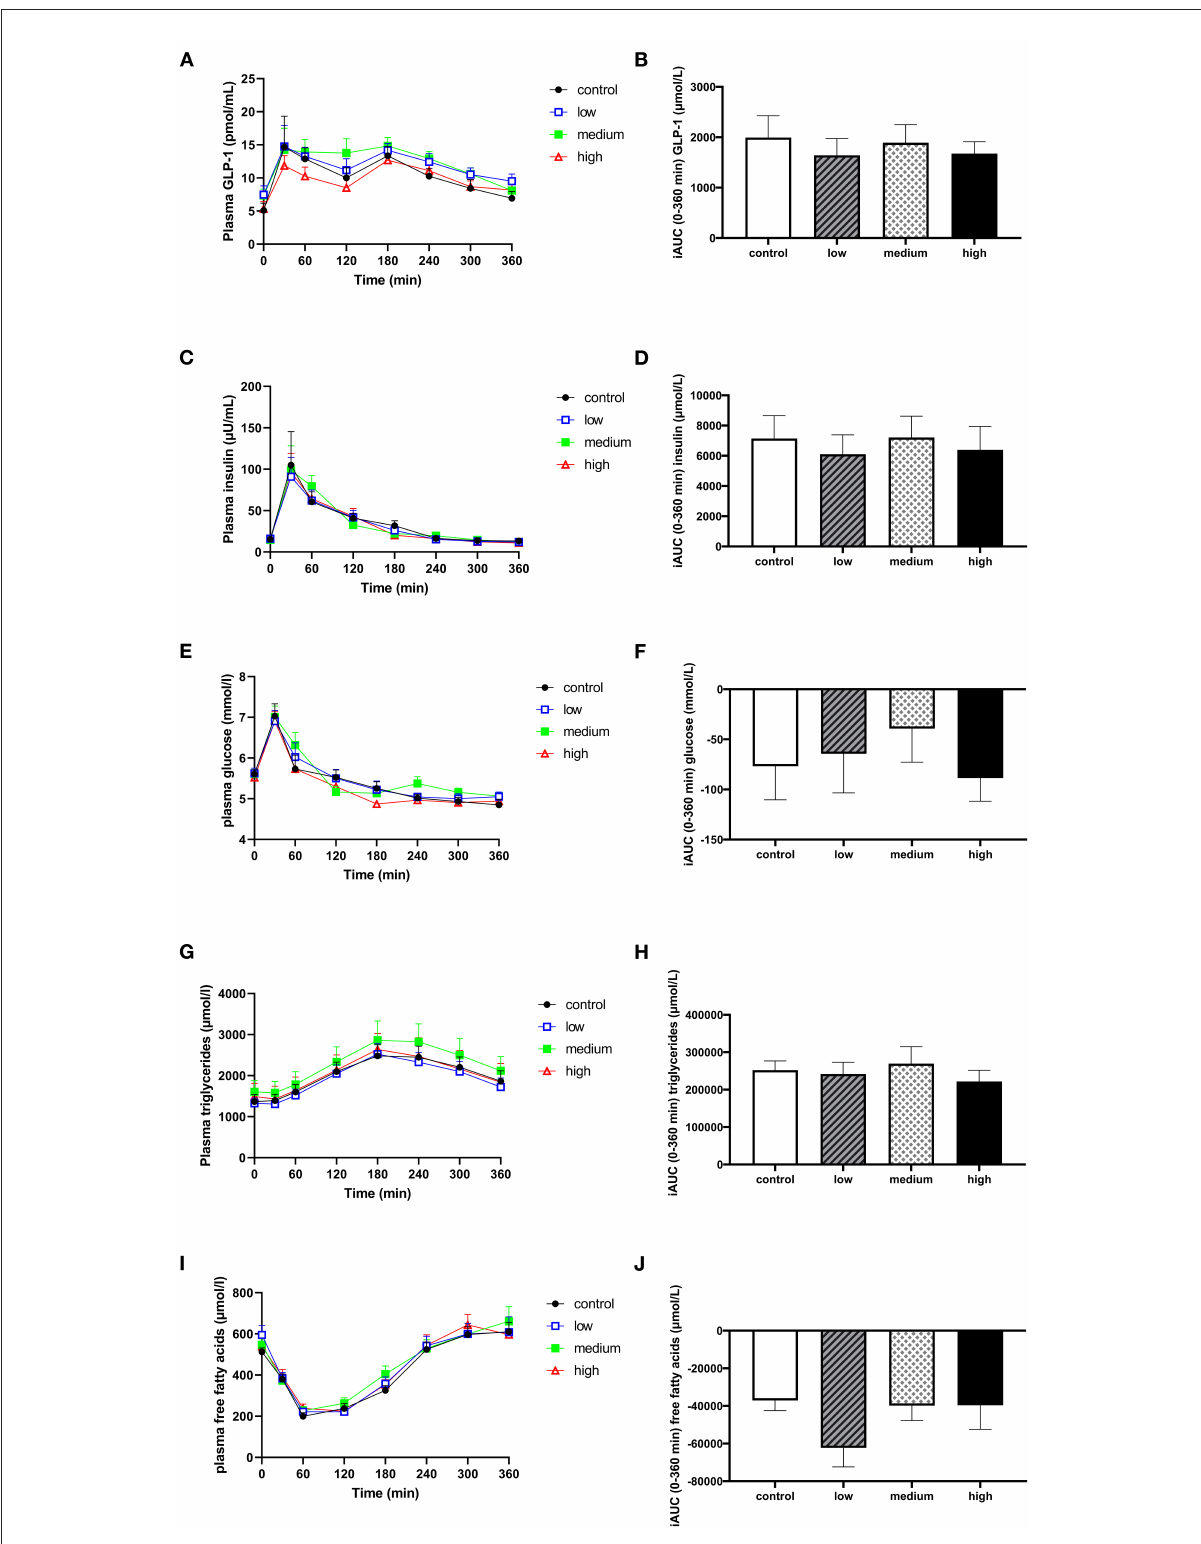
FIGURE5 The effect of butyrate and hexanoate-enriched triglycerides on circulating GLP-1 (A, B) and metabolic parameters: insulin (C, D) , glucose (E, F) , triglycerides (G, H) , and free fatty acids (I, J) . (A) Postprandial plasma GLP-1 concentrations (t0–t360min) after butyrate and